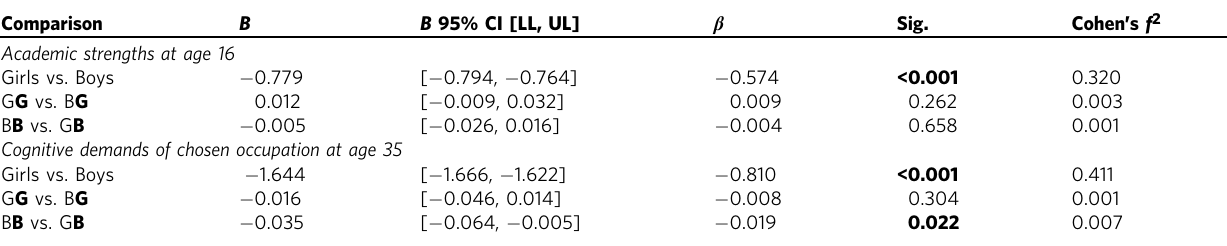
Table 3 Regression table summarizing the differences in academic strengths and cognitive demands of chosen occupation grouped by sex (across sexes) and sibship composition (within sexes) in Study 2.